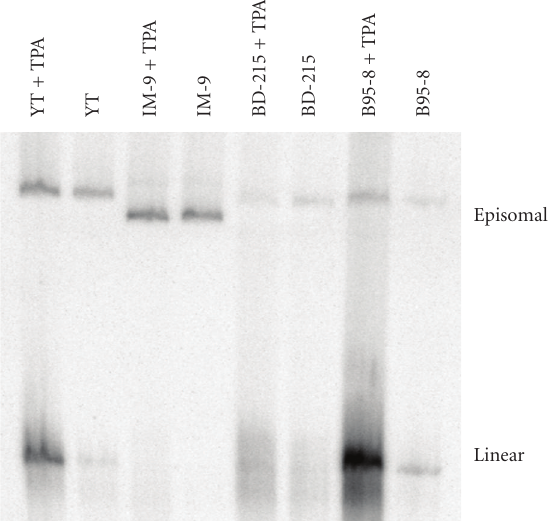
Figure 5: Detection of circular and linear EBV DNA in untreated and TPA-treated cell lines by in situ lysing gel analysis. Cells were stimulated for 72hours with 10 − 7 M TPA and 0.3 M Na-butyrate. All conditions were as described in the legend for Figure 3. The cell lines B95-8 and YT can be e ffi ciently stimulated to produce high amounts of linear EBV genomes, whereas BD-215 cannot be triggered to produce more linear DNA and IM-9 is not induced to produce linear DNA by TPA/Na-butyrate.